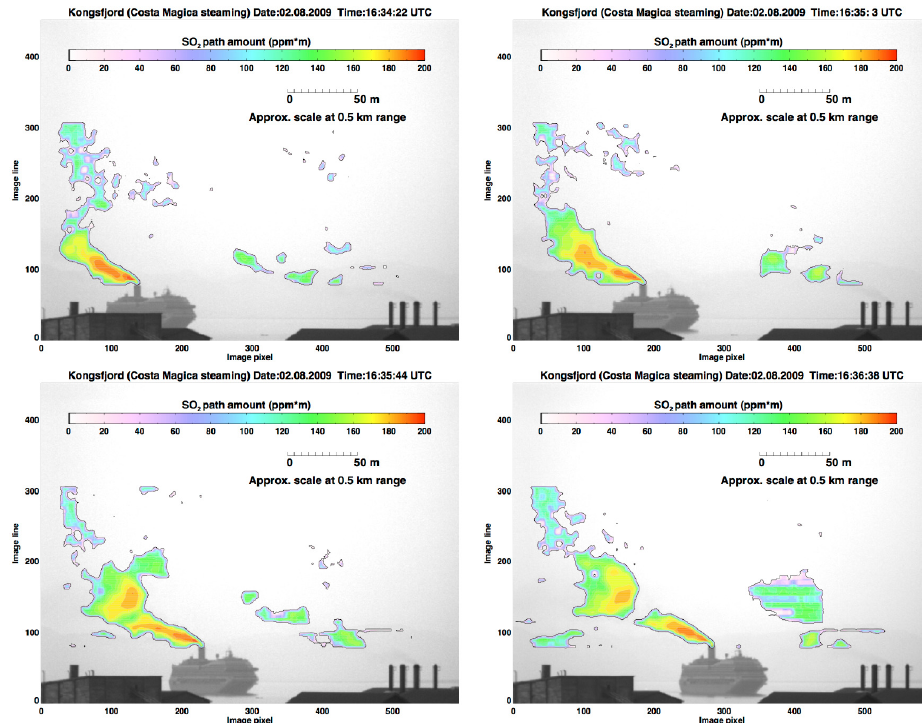
Fig. 7. SO 2 path amounts retrieved from the UV camera for a cruise ship steaming into Kongsfjord. Ny